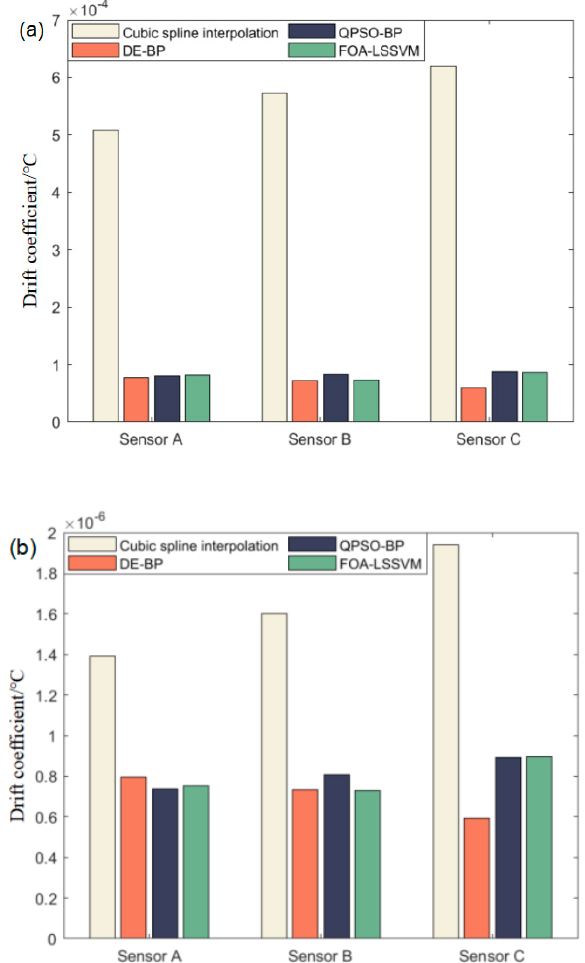
Figure 10. Comparison of different sensors: ( a ) zero-drift coefficient; ( b ) sensitivity temperature coefficient.